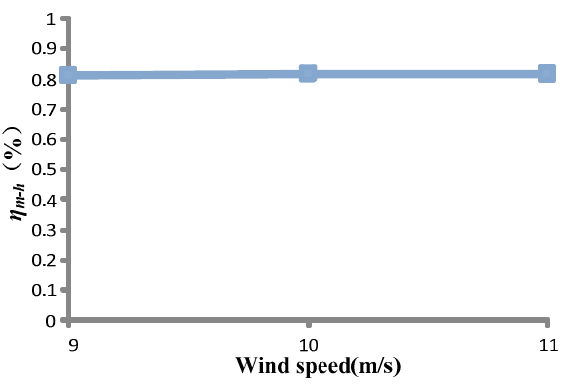
Figure 13. Efficiency of the mechanical-hydraulic system comparison at different wind speeds.